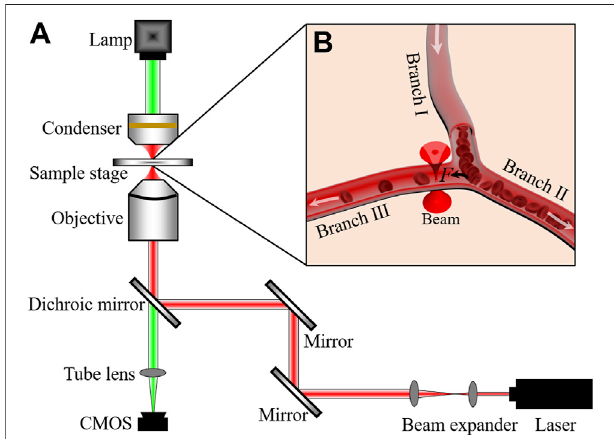
FIGURE 1 | (A) Optical tweezers setup. (B) Schematic illustration of blood fl ow controlled by optical trap. White arrows indicate the directions of blood fl ows. F is the optical trapping